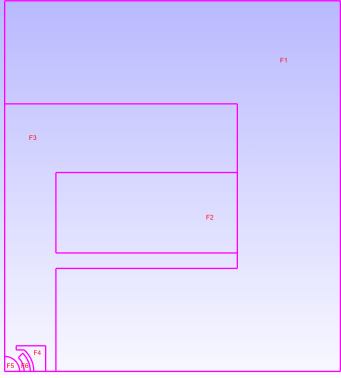
Figure 17. Modeled geometry of the die press.